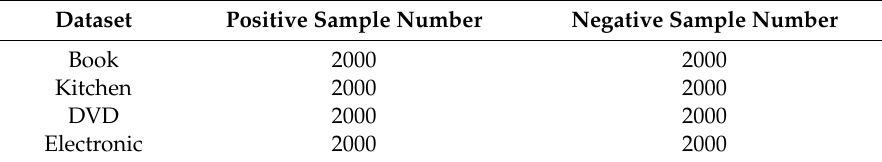
Table 2. English experimental